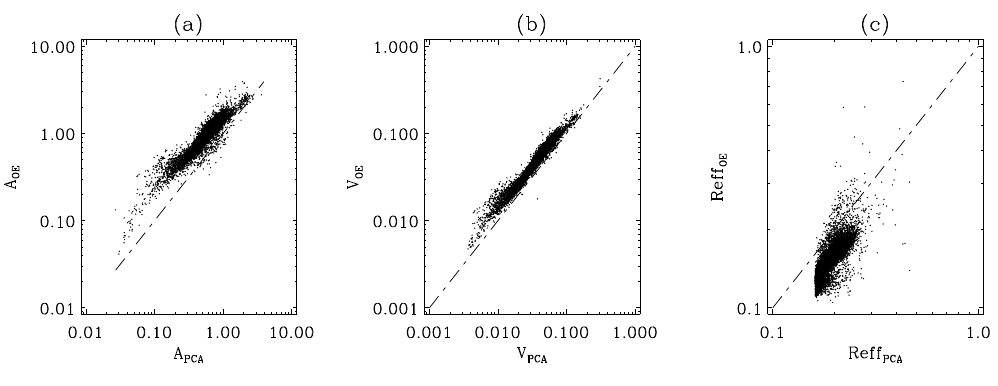
Fig. 12. SAGE II measurements (December 1999): Principal Component Analysis (PCA) retrieval results of surface area density in µm 2 cm − 3 , effective radius R eff in µm (courtesy of NASA LaRC) and the associated volume density in µm 3 cm − 3 , compared to the Optimal Estimation retrieval results. The diagonal line marks x = y where both results would be identical.